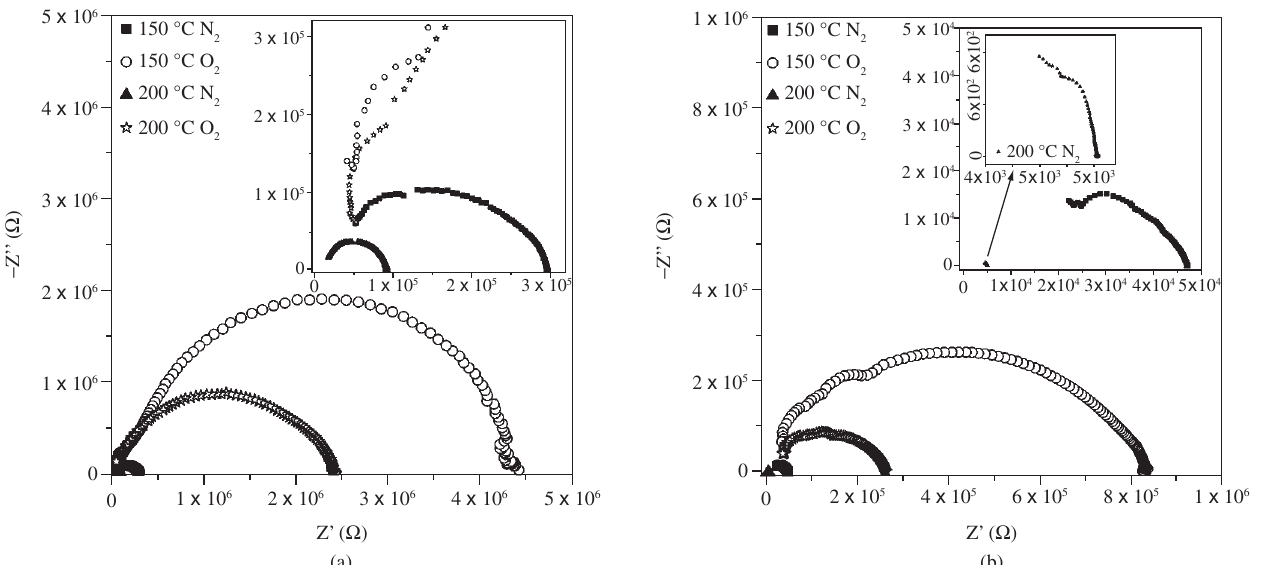
Figure 6. Nyquist plots of the: a) nanocrystalline sputtered and b) microcrystalline doctor bladed films measured in oxygen and nitrogen atmosphere at 150 and 200